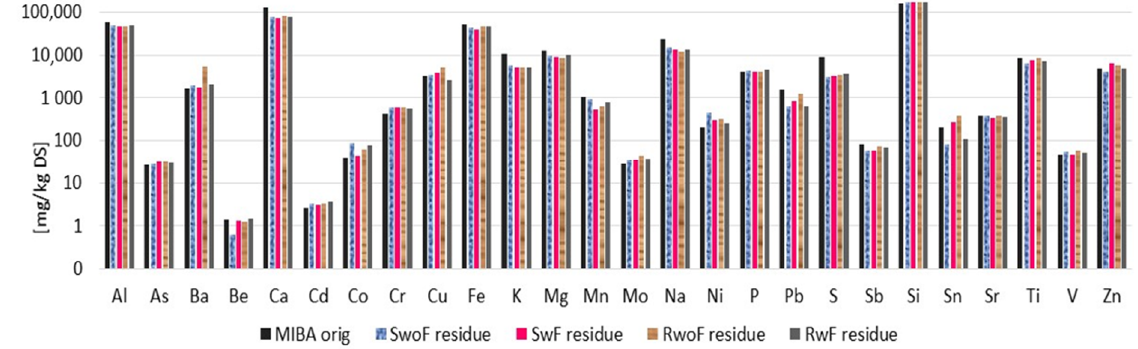
Figure 4. Contents (mg/kg DS) of selected elements in MIBA before and after cultivation of sunflowers and rapeseed.